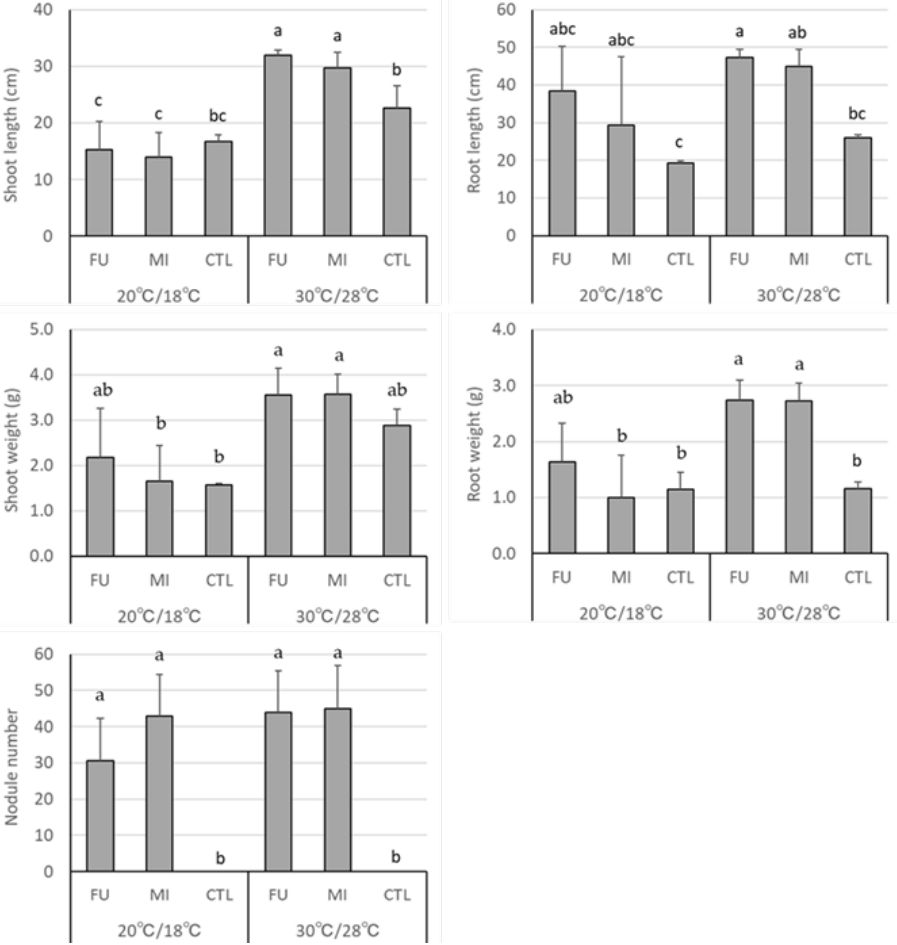
Figure 3. Effects of temperature on growth and nodule number of soybean inoculated with a mixture of the Bradyrhizobium spp. strains. Soybean was cultivated in a phytotron at 20/18 ◦ C (day/night) and 30/28 ◦ C at 16/8 h cycle. Fukagawa strains: B. japonicum Hh 16-9 (Bj11-1), B. japonicum Hh 16-25 (Bj11-2), and B . elkanii Hk 16-7 (BeL7); Miyazaki strains: B. japonicum Kh 16-43 (Bj10J-2), B. japonicum Kh 16-64 (Bj10J-4), and B. elkanii Kh 16-7 (BeL7); control: no inoculation. The bars represent the standard deviation ( n = 3) and different letters indicate significant differences at p < 0.05 by Duncan’s test.